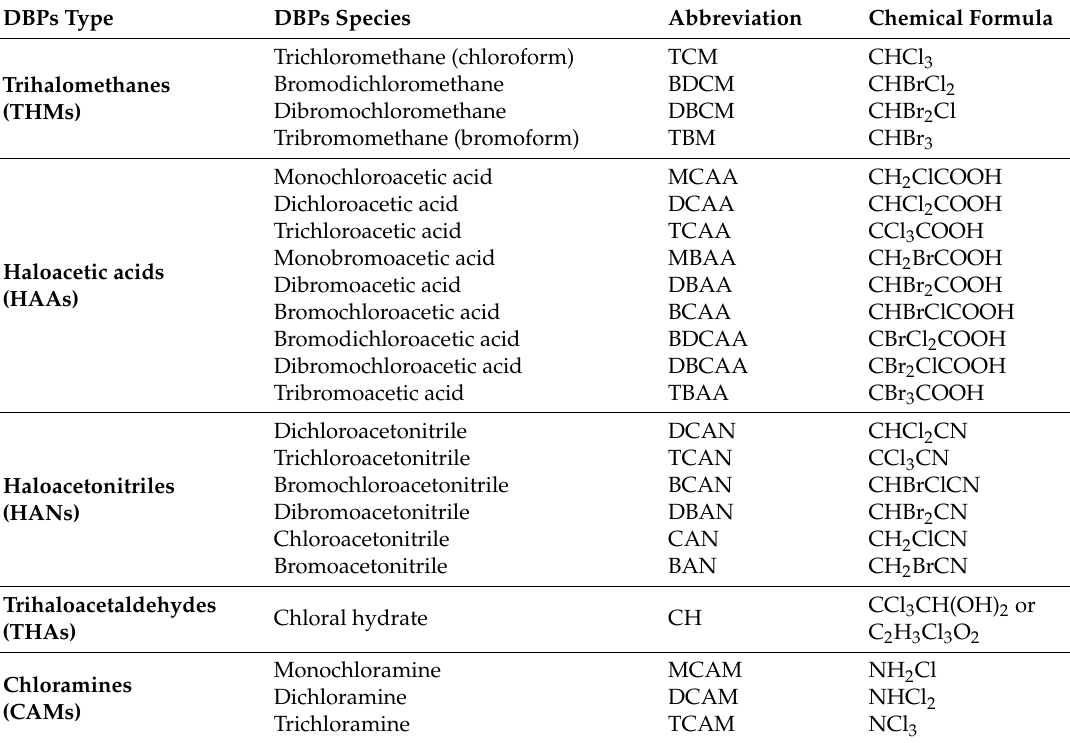
Table A1. Types and species of DBPs studied in this review.